Question: What visual encoding does this figure use to show its data?
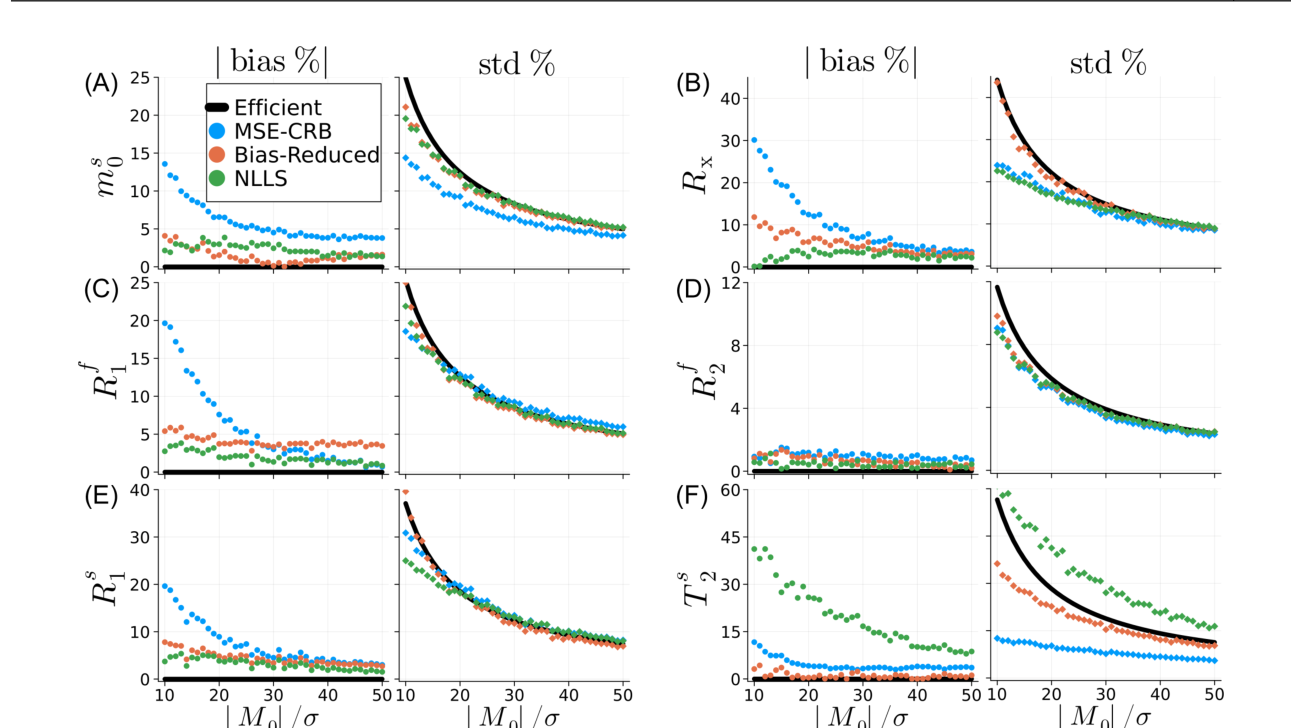
Answer: line